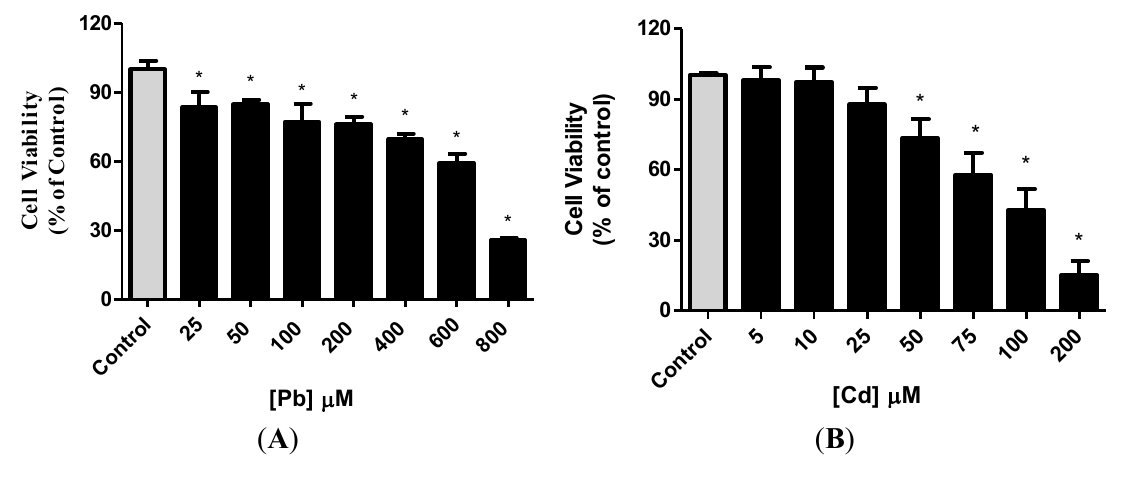
Figure 1. Cell viability of hCMEC/D3 cells. Dose-response for ( A ) Pb-induced cytotoxicity and ( B ) Cd-induced cytotoxicity. Cell viability was quantified using Calcein AM assay. Cells were exposed to different concentrations of Pb (25–200 µM) and Cd (10–100